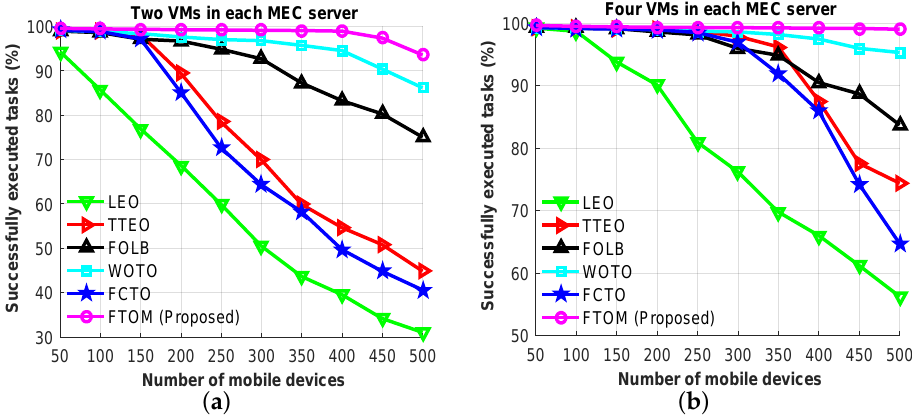
Figure 14. Successfully executed tasks versus the number of mobile devices: ( a ) with two VMs in each MEC server; ( b ) with four VMs in each MEC